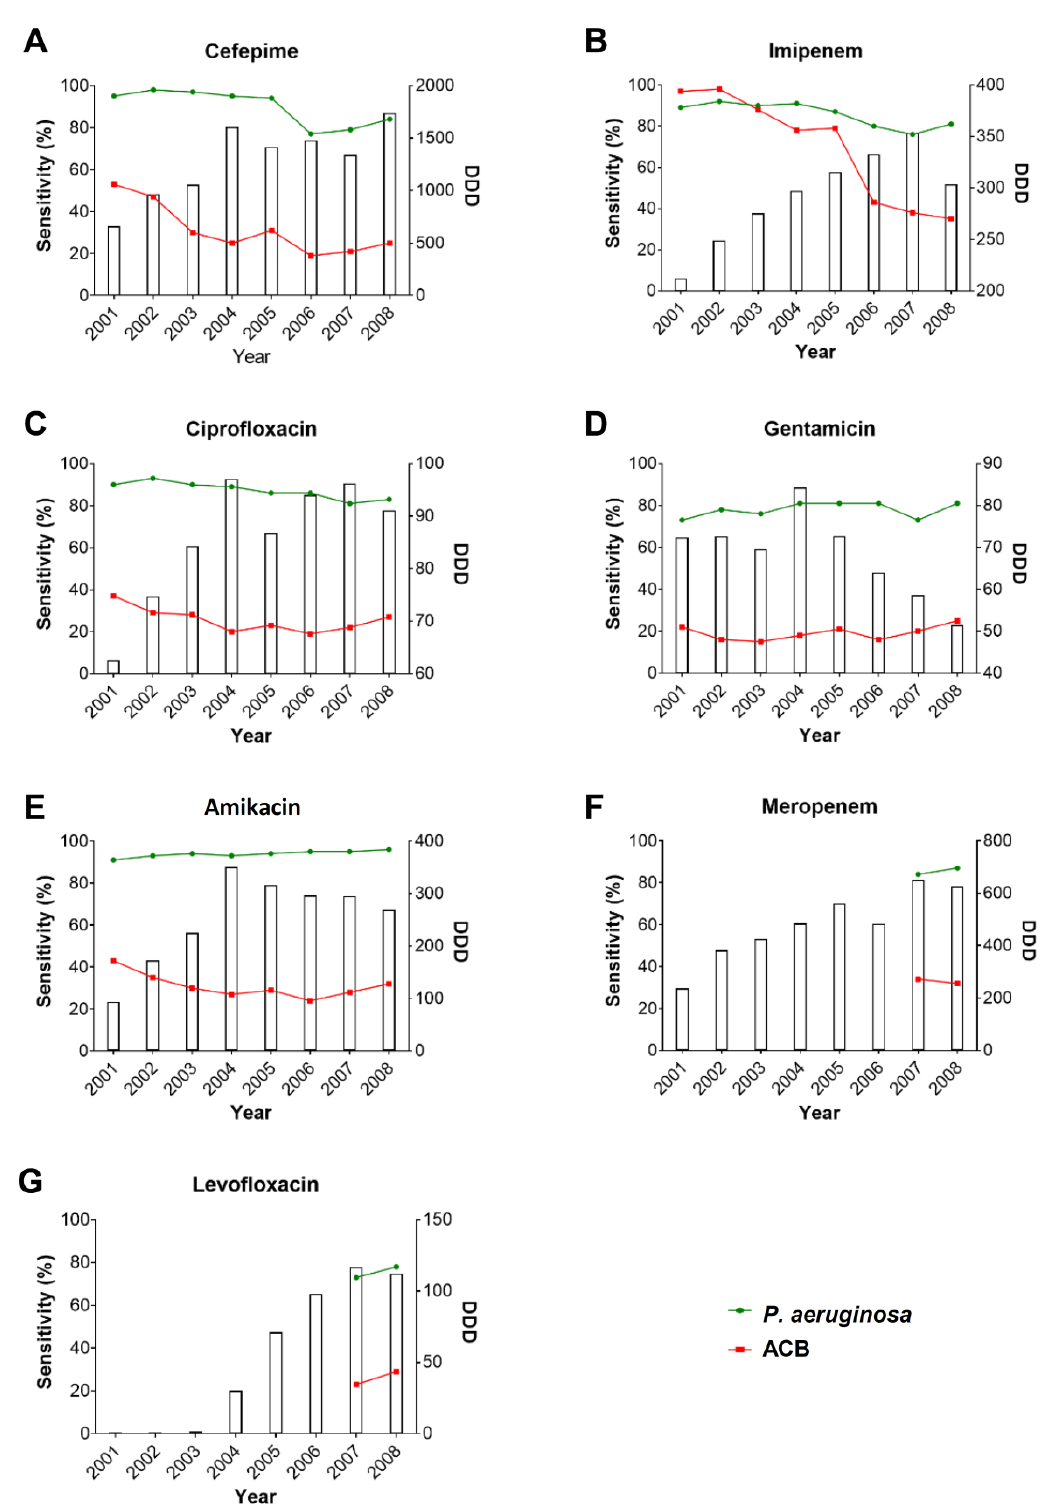
Figure 3. The annual prescriptions of antibiotics and antibiotic susceptibility of ACB and P. aeruginosa . Total prescribed DDDs of ( A ) cefepime, ( B ) imipenem, ( C ) ciprofloxacin, ( D ) gentamicin, ( E ) amikacin, ( F ) meropenem, and ( G ) levofloxacin were analyzed from the National Health Insurance Research Database (NHIRD). Bars indicate the annual consumption of antimicrobials (DDDs). Green lines and red lines represent the sensitivity of P. aeruginosa and ACB to antimicrobial agents, respectively.